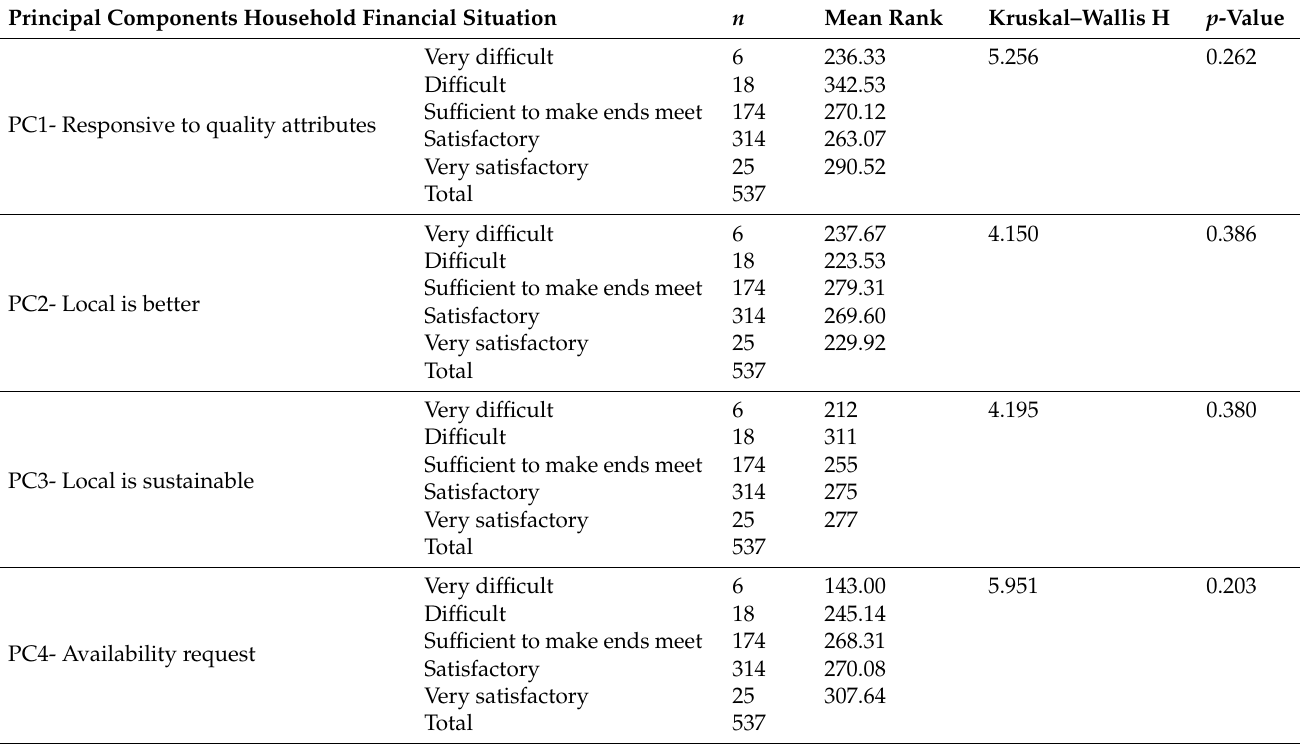
Table 7. Effect of household financial situation on the principal components’